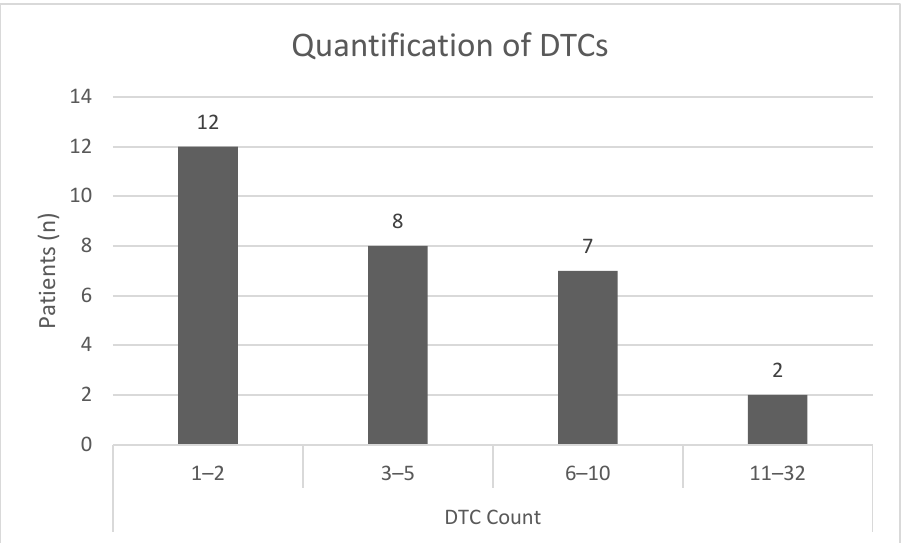
Figure 6. Quantification of DTCs per patient and division into subgroups defined by the number of DTCs detected in a bone marrow sample using sequential immunofluorescent staining.